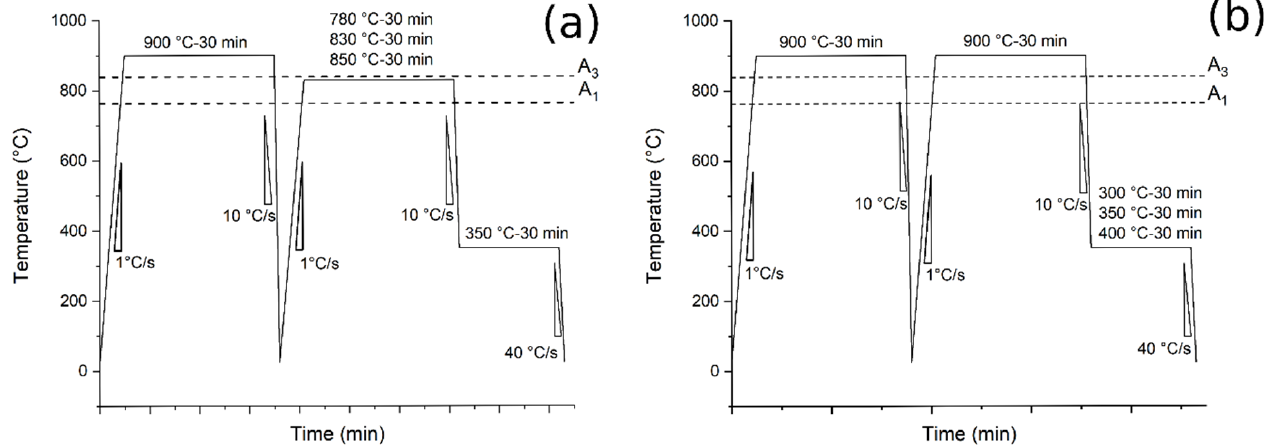
Figure 1. Heat treatments scheme: ( a ) the tests performed at different austenitizing and fixed austempering temperatures (route 1); ( b ) the tests performed at fixed austenitizing and different austempering temperatures (route 2).